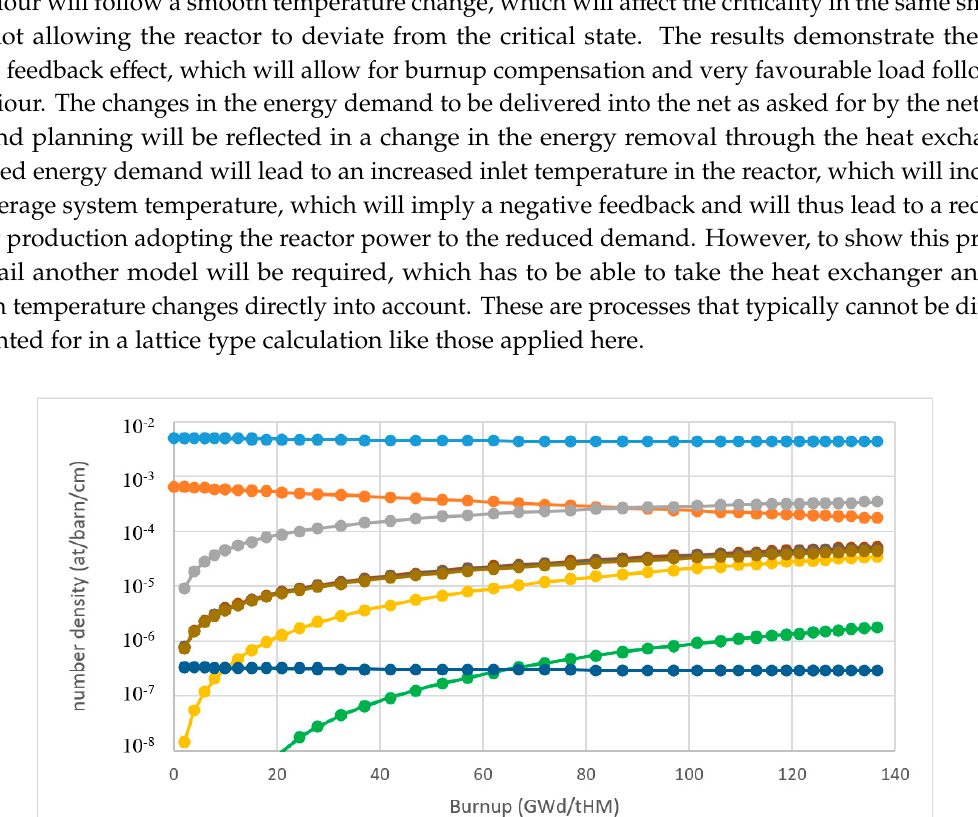
Figure 7. Composition changes over burnup for major fissile, fertile isotopes and fission products over burnup for the temperature varied system with the criticality given on the left axis and the system averaged temperature on the right axis for the close to eutectic system.